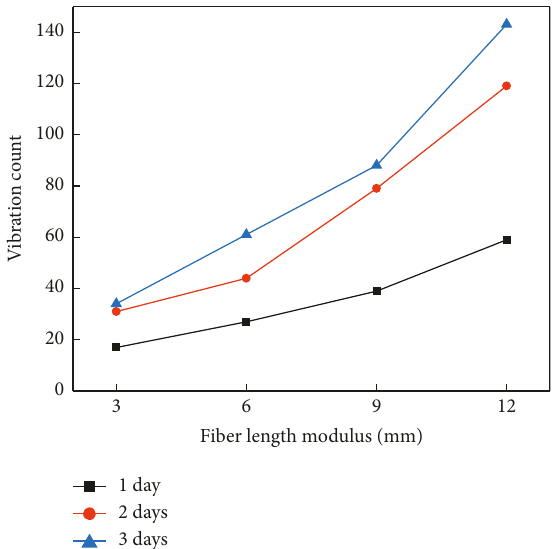
Figure 10: Variation of the number of vibrations of consolidated remolded soils with fiber length modulus at different conservation ages.